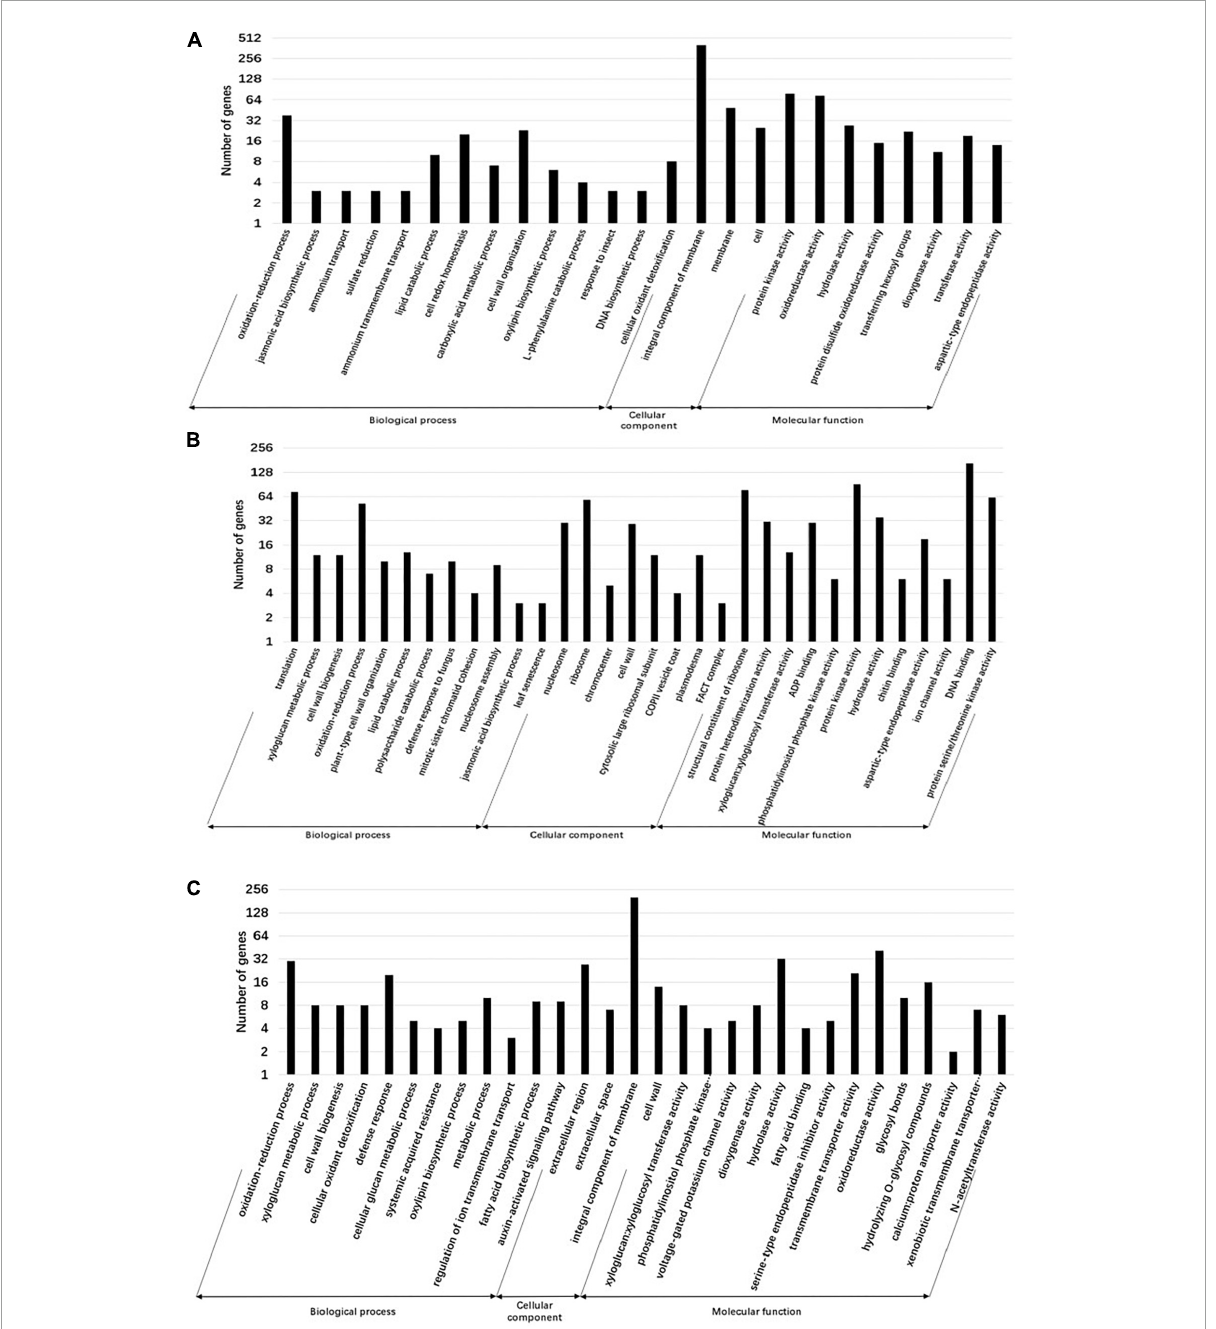
FIGURE4 Gene ontology (GO) annotation of differentially expressed genes (DEGs) for different treatments. Genes are divided into the following three major functional categories: biological process, cellular component, and molecular function. The bars represent the enriched gene numbers in major sub-categories within each GO category. (A) GO classifications of differential genes in the jasmonate acid (JA) vs. mock group. (B) GO classifications of differential genes in the salicylic acid (SA) vs. mock group. (C) GO classifications of differential genes in the coronatine (COR) vs. mock